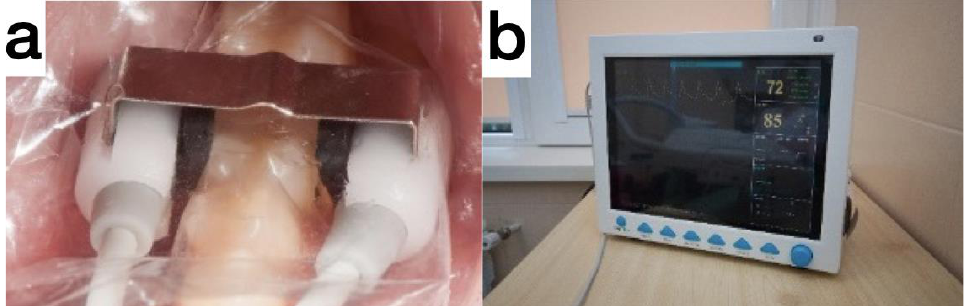
Figure 2. ( a ) The LED is placed buccally in the cervical region of the tooth, and the photodetector is placed orally at the same level. ( b ) On the screen, the saturation level of the pulp is represented as a percentage, indicative of the condition of the pulp.